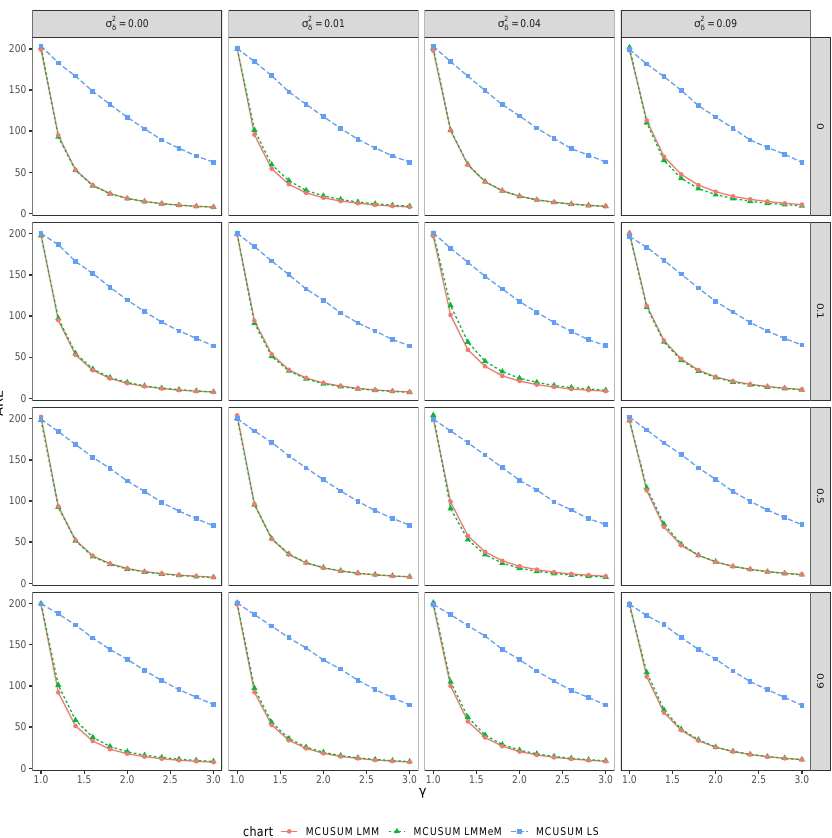
Figure 6. Effect of ignoring measurement errors and random effects on ARL performance for MCUSUM control chart under different shifts in standard